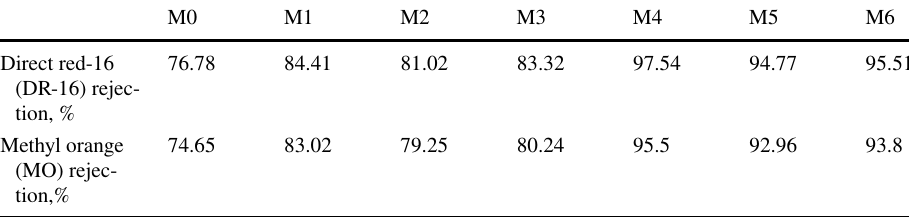
rejection by the membranes